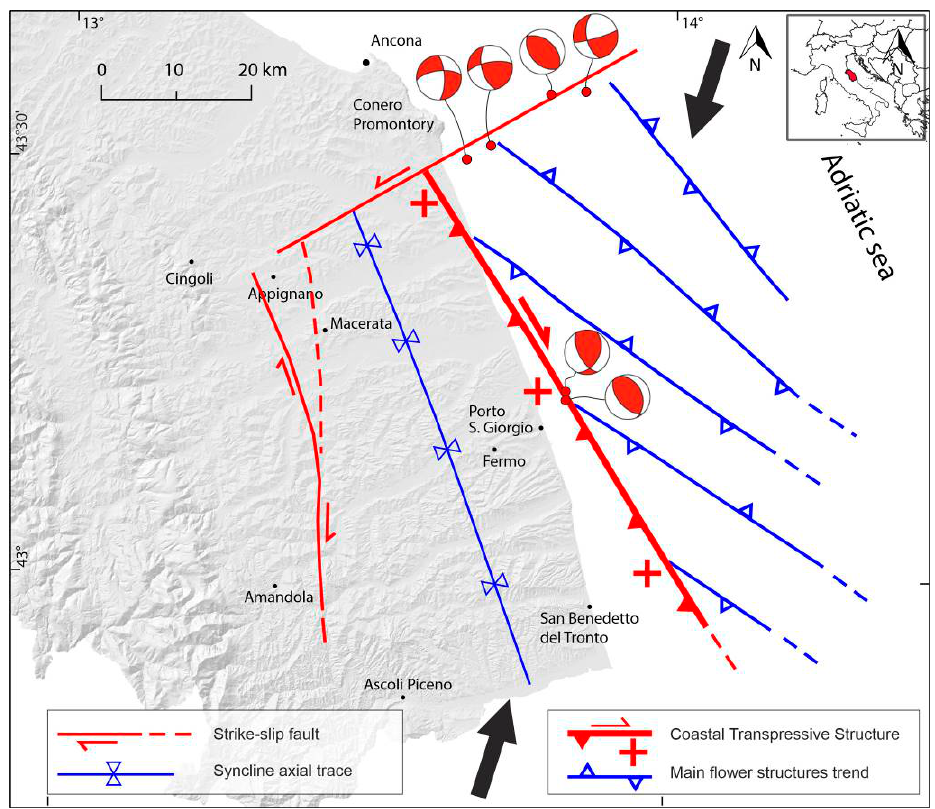
Figure 12. Kinematic sketch map. Red lines indicate fault systems still active during the Quaternary. The black arrow represents the main shortening direction, red arrows describe the right lateral strike–slip component, and the plus symbol (+) is the narrow strongly uplifted area. Focal mechanisms (beach balls) of the main earthquakes of 1987 Porto S. Giorgio and 2013 south of Conero seismic sequences are shown.